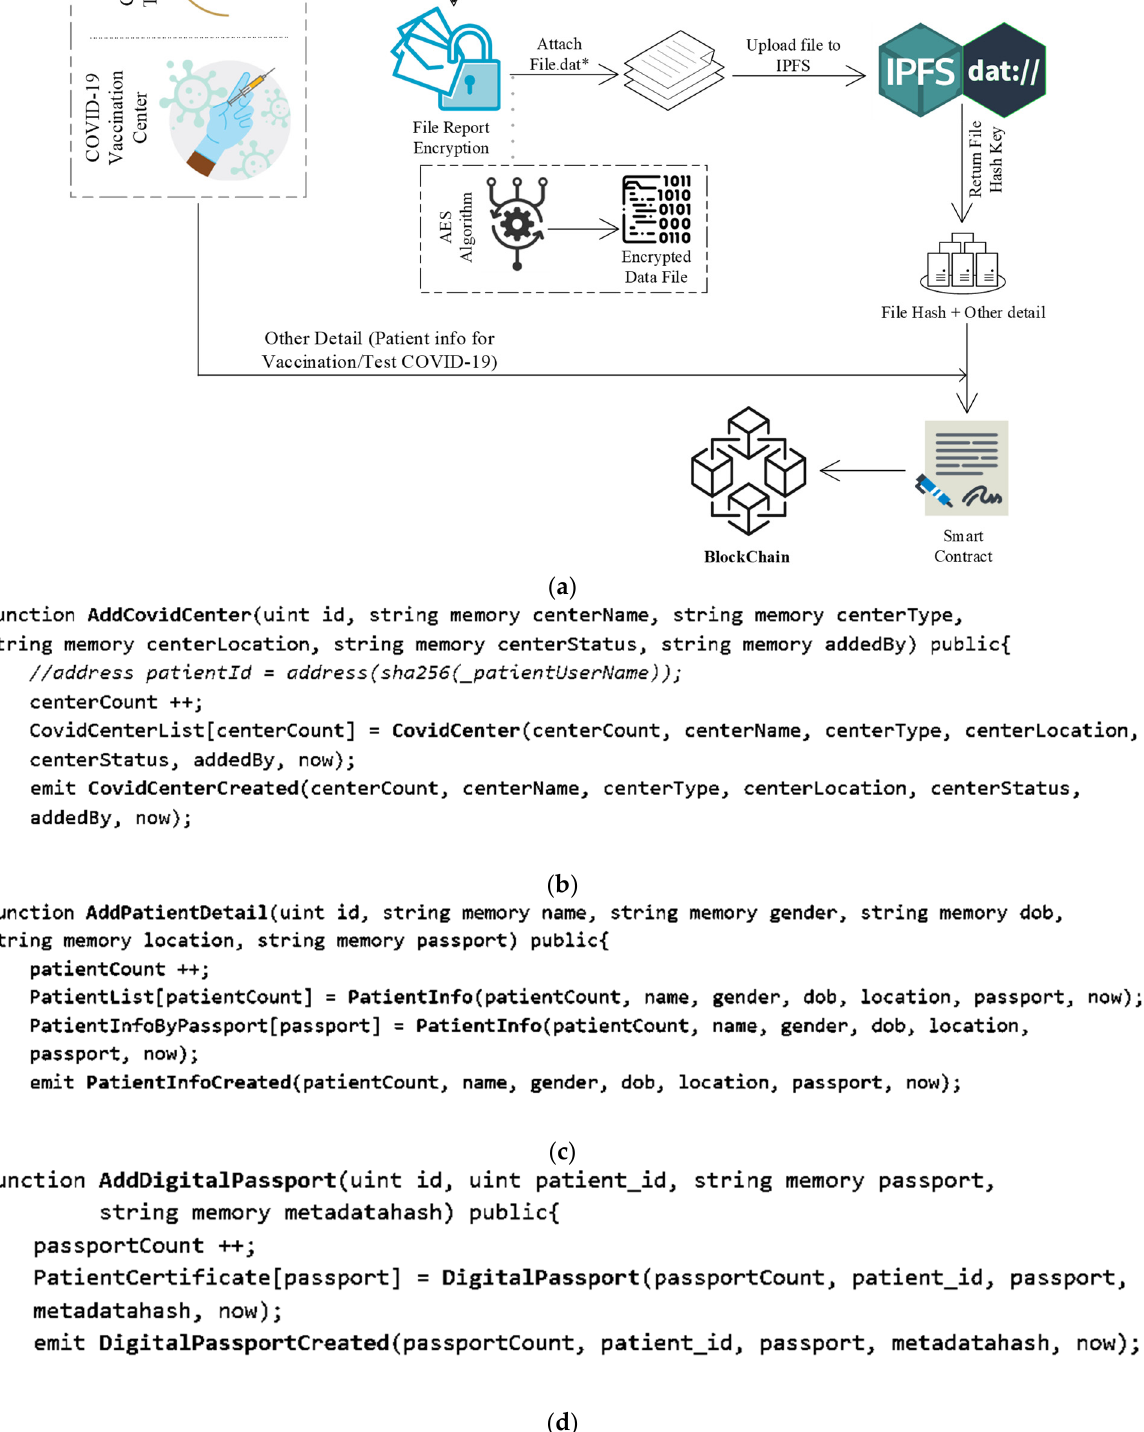
Figure 4. ( a ) Data storing process. ( b ) Smart contract function for adding centers. ( c ) Smart contract function for adding detail of patient. ( d ) smart contract function for creating digital passport.